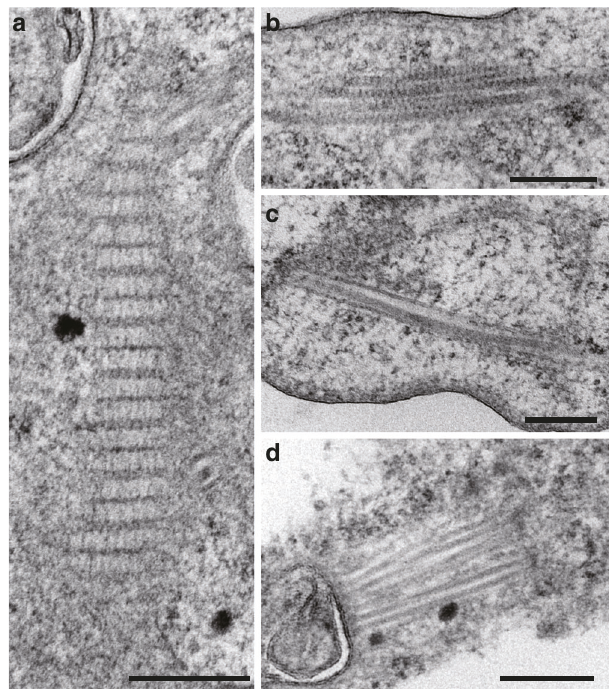
Fig. 5 Fibrous structures in ‘ Candidatus Uab amorphum ’ . a Large striated fi bre. b Small striated fi bre. c Short bundled fi bre. d Cylindrical structures containing a linear fi bre. Scale bars, 200